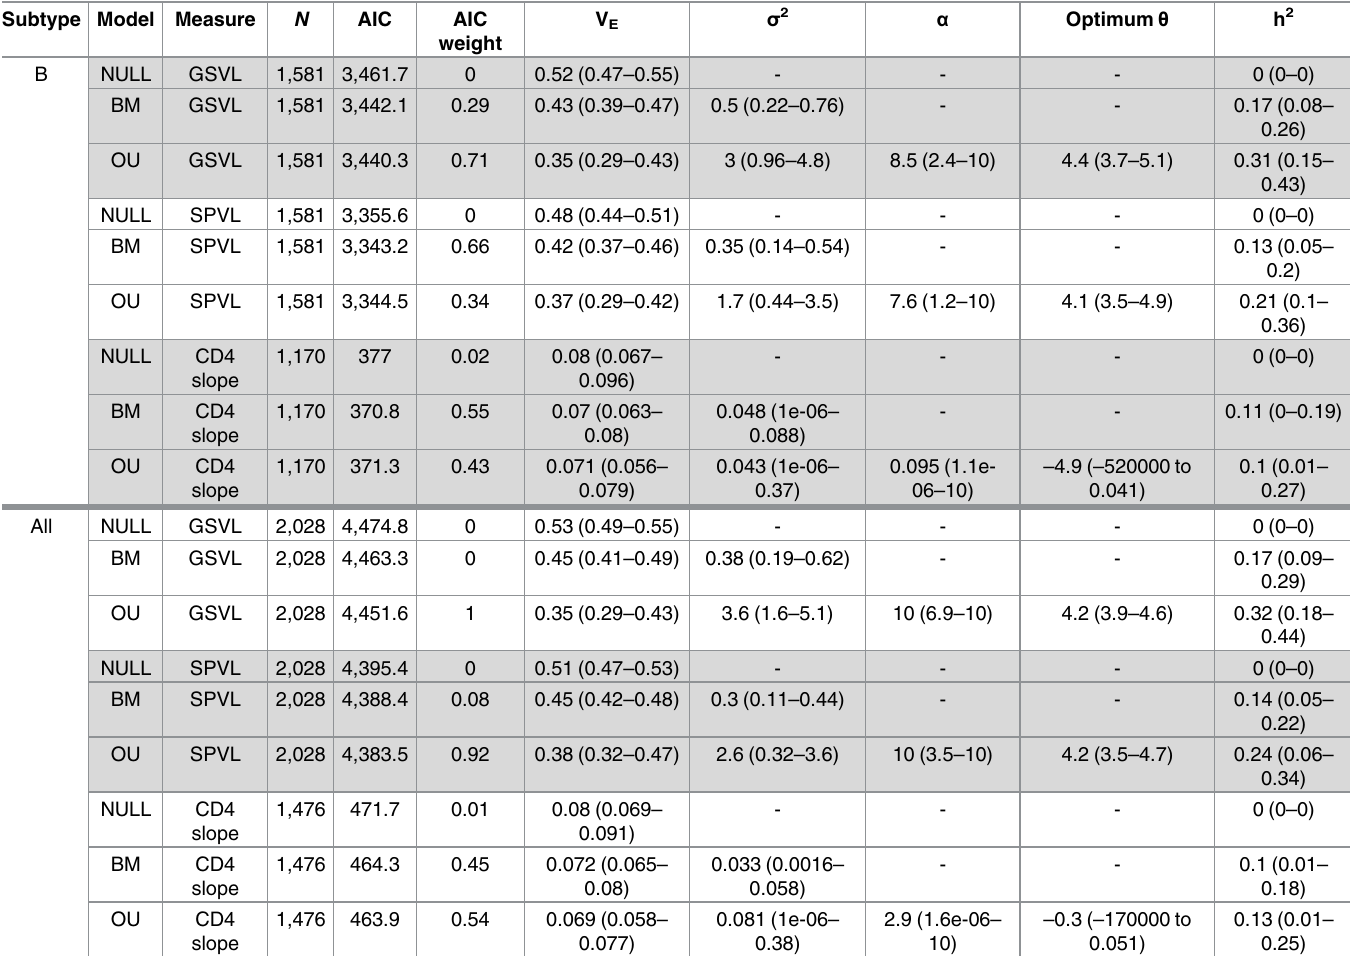
Table 1. Summaryof model fit for the subset of subtype B viruses and for all subtypes. Subtype Model